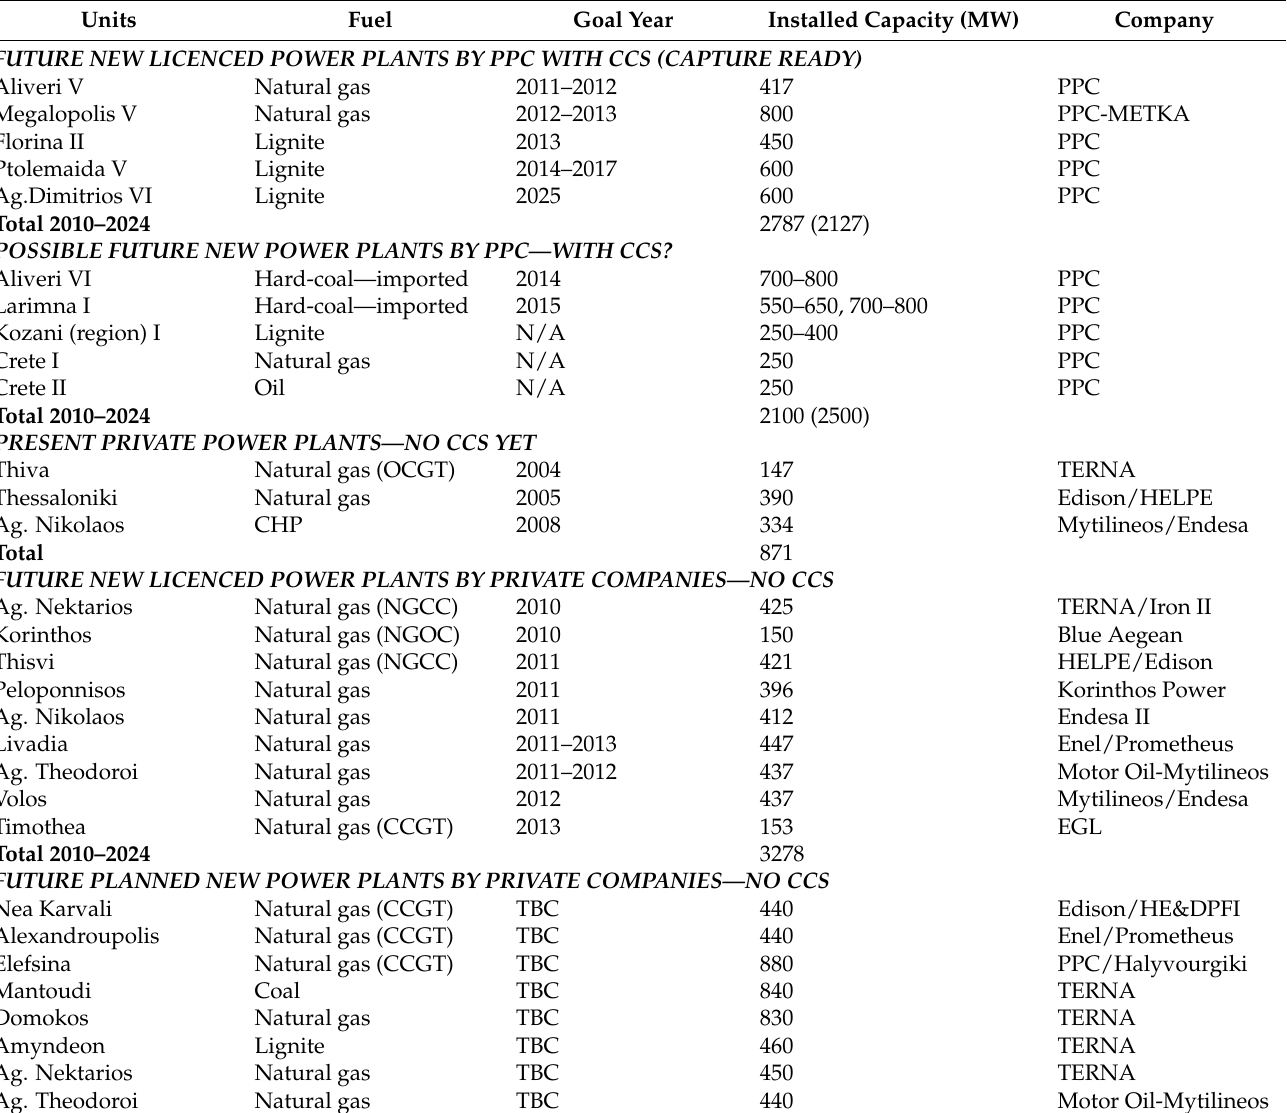
Table 6. Future thermal power stations (interconnected system) in Greece